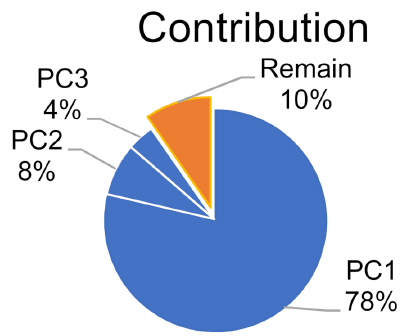
Figure 6. Contribution of principal components.